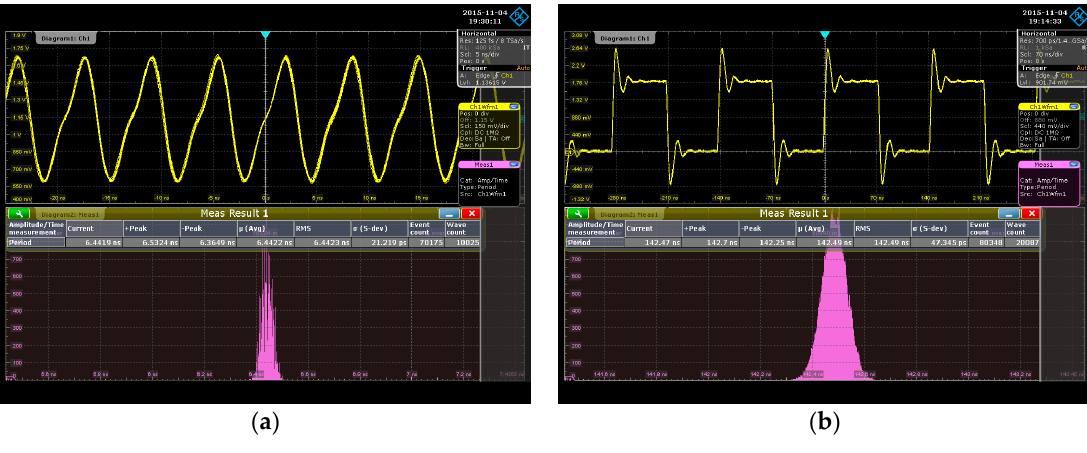
Figure 11. Jitter histogram at ( a ) 155 MHz and ( b ) 7 MHz. Table 3. Performance comparisons.